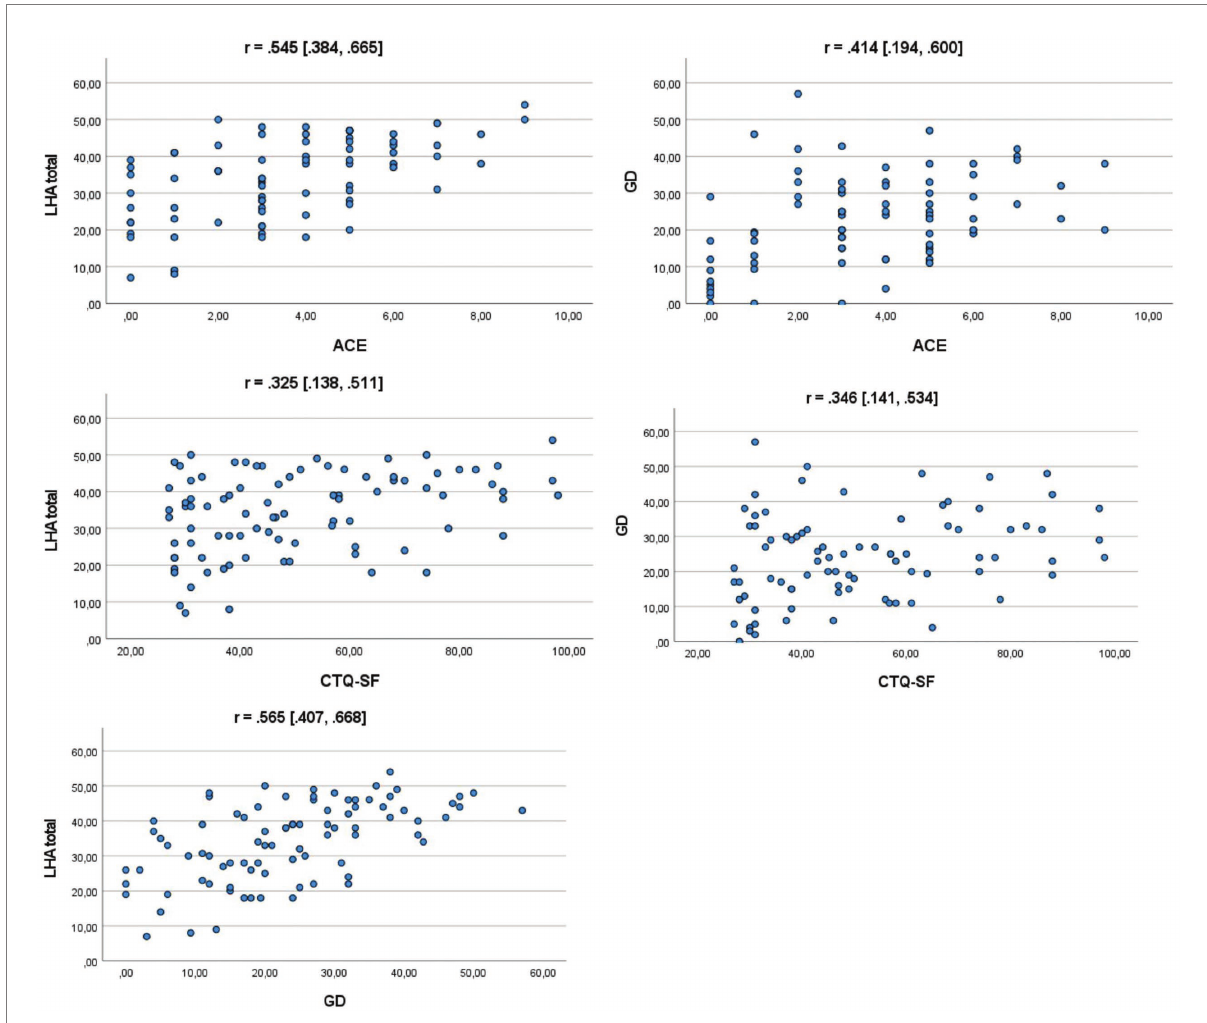
FIGURE 1 Scatterplots depicting associations between study variables. LHA total = total score on the Life History of Aggression questionnaire, CTQ-SF, Childhood Trauma Questionnaire-Short Form; ACE, Clinically assessed scale of adverse childhood experiences; GD, general disinhibition; r, Spearman’s rho with bootstrapped confidence intervals in square brackets.